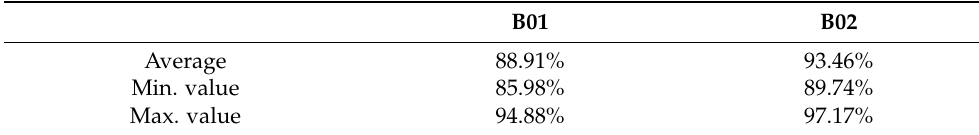
Table 6. B-tests image comparison data.